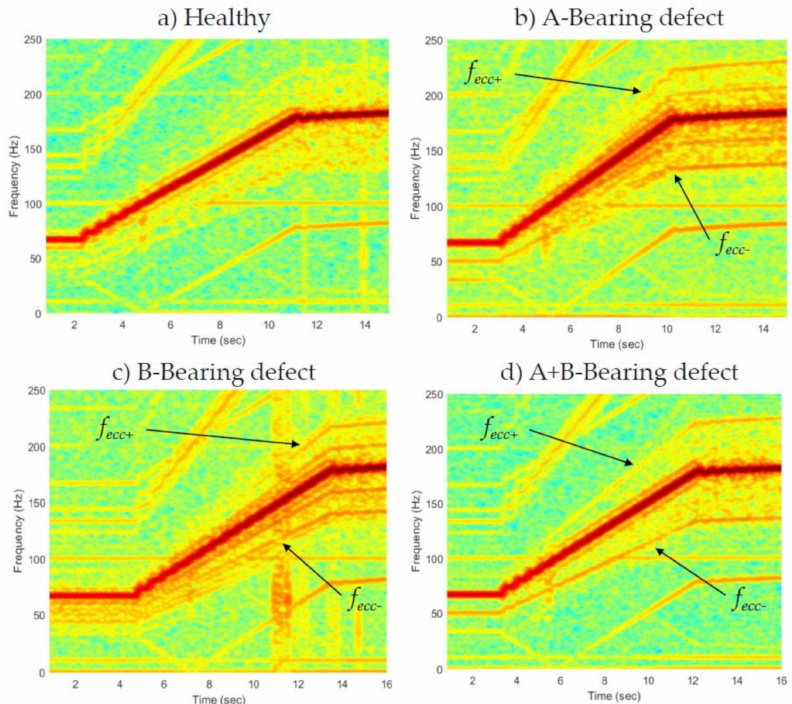
Figure 12. Time-frequency analysis of the stator current in healthy condition and of different variants bearing defects.